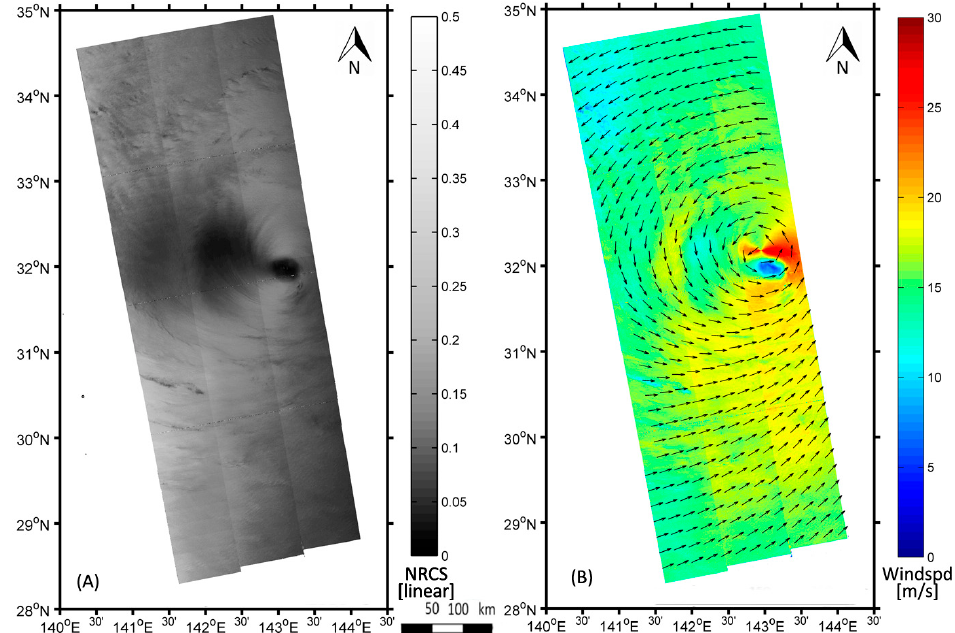
Figure 1. Windfield retrieved from Sentinel-1A synthetic aperture radar (SAR) Extra-wide Swath Mode data on 29 August 2016 at 08:32 UTC. ( A ) Sea surface radar backscattering map; ( B ) the SAR derived sea surface wind map.